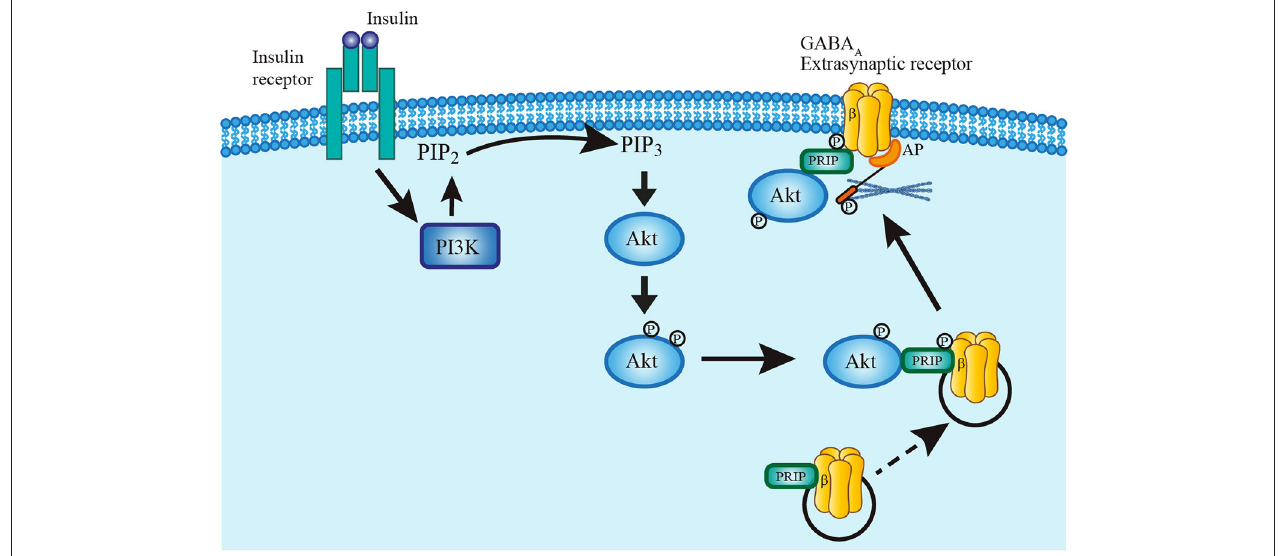
FIGURE 8 | Model describing insulin mechanism of GABA A receptor translocation. Insulin binding to its receptor activates PI3K pathway which in turn phosphorylates PIP2 converting it to PIP3. PIP3 recruits Akt into the plasma membrane to rapidly phosphorylate GABA A receptors at the β subunit. Phospholipase-C-related catalytically inactive protein (PRIP) has a key role in the translocation mechanism by coupling Akt and phosphorylating GABA A receptors. The complex is then translated and fixed to the plasma membrane by mean of an anchoring protein (AP) which also binds to the cytoskeleton (Hausrat et al.,